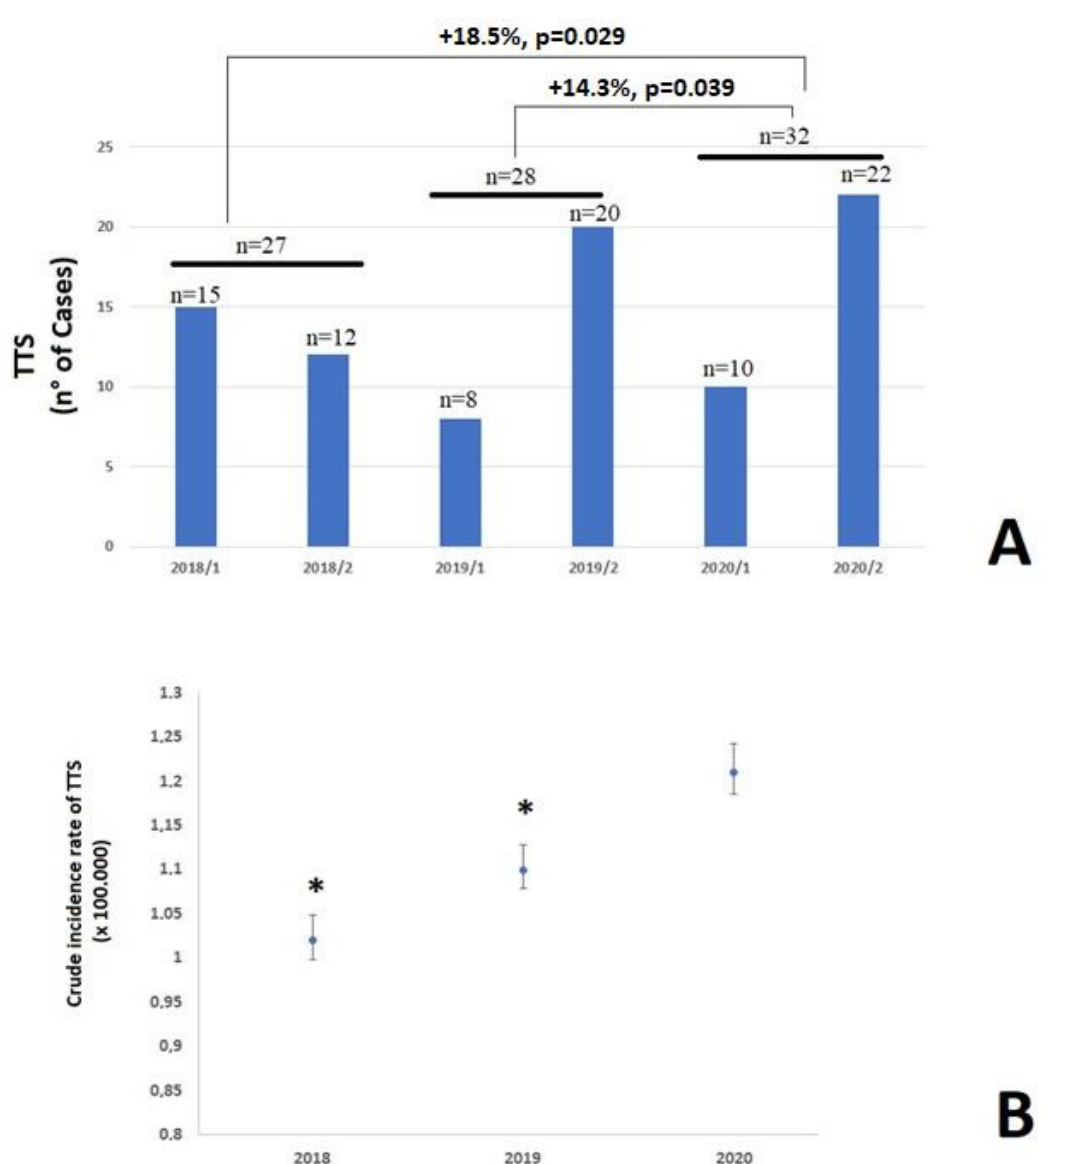
Figure 1. ( A ) Trends in Takotsubo syndrome hospital admission in Veneto region. Periods: 2018/1: Crude incidence of Takotsubo syndrome over the years in Veneto region (per 100,000 inhabitants). * p < 0.05 compared to 2020; p for difference between 2018 vs 2019 = 0.621.